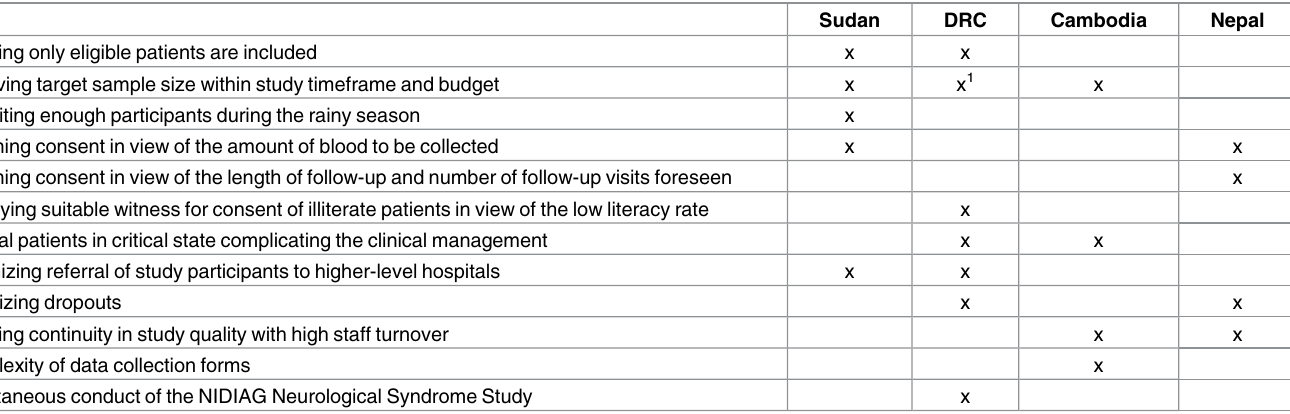
Table 3. Challenges encountered by the clinical staff during the NIDIAG persistent fever syndrome